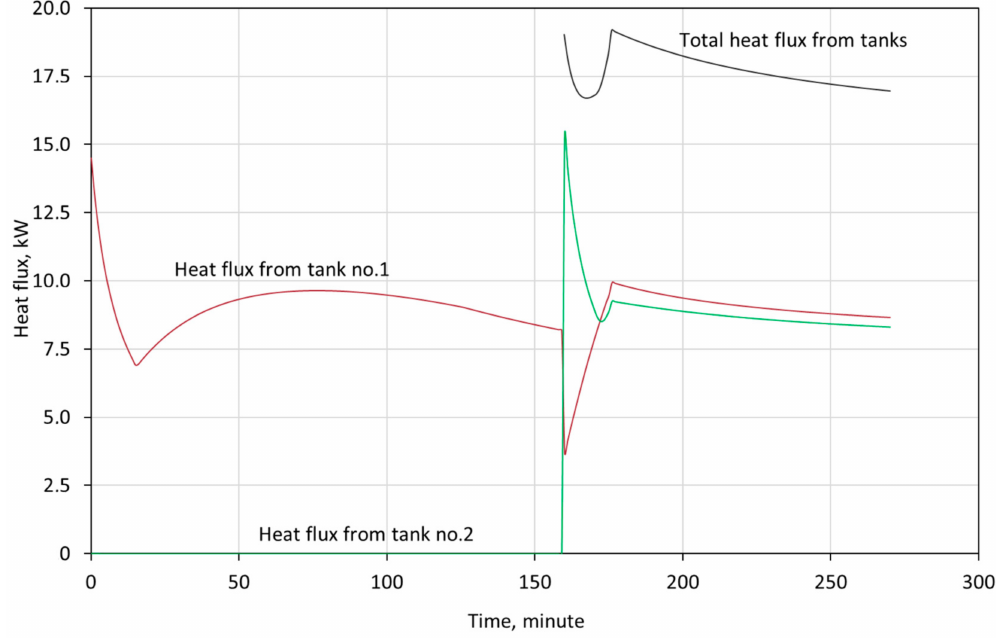
Figure 5. The heat flux transferred between the water and the PCMs in the storage tanks during their